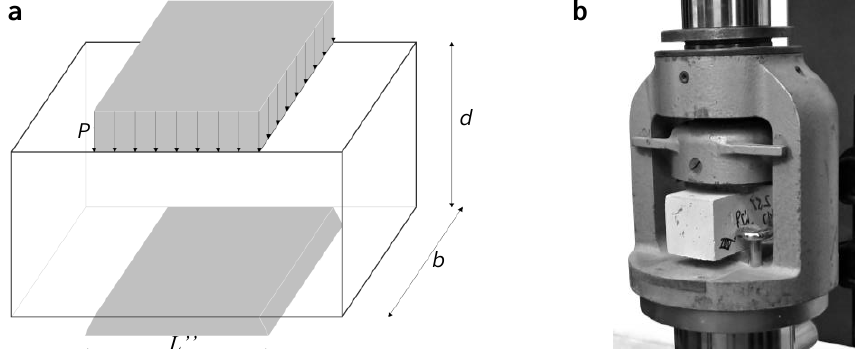
Figure 4. ( a ) scheme employed for the Compression Test (CT); ( b ) picture of the CT carried out at the LPMS of L’Aquila.